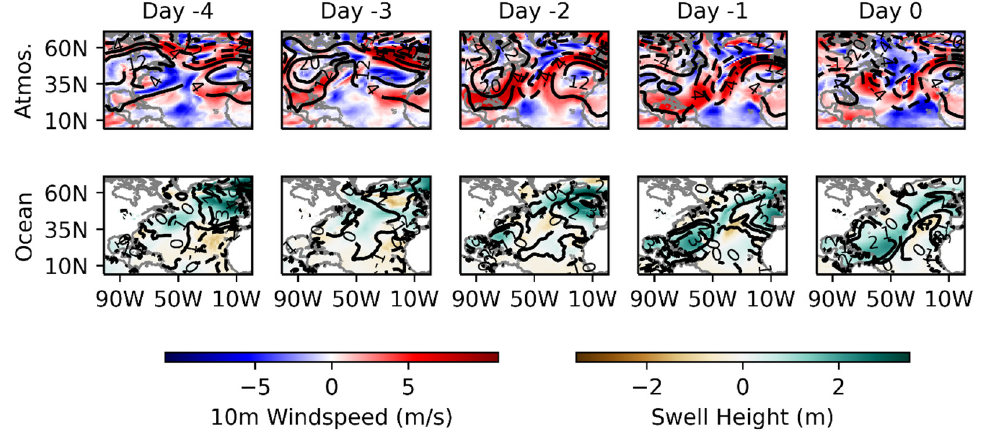
Figure 15. Same as Figure 10 except anomaly for the single high pressure induced, low probability north swell event (day 0 = 12/22/1991). Day 0 is the day that was classified as a north swell day.